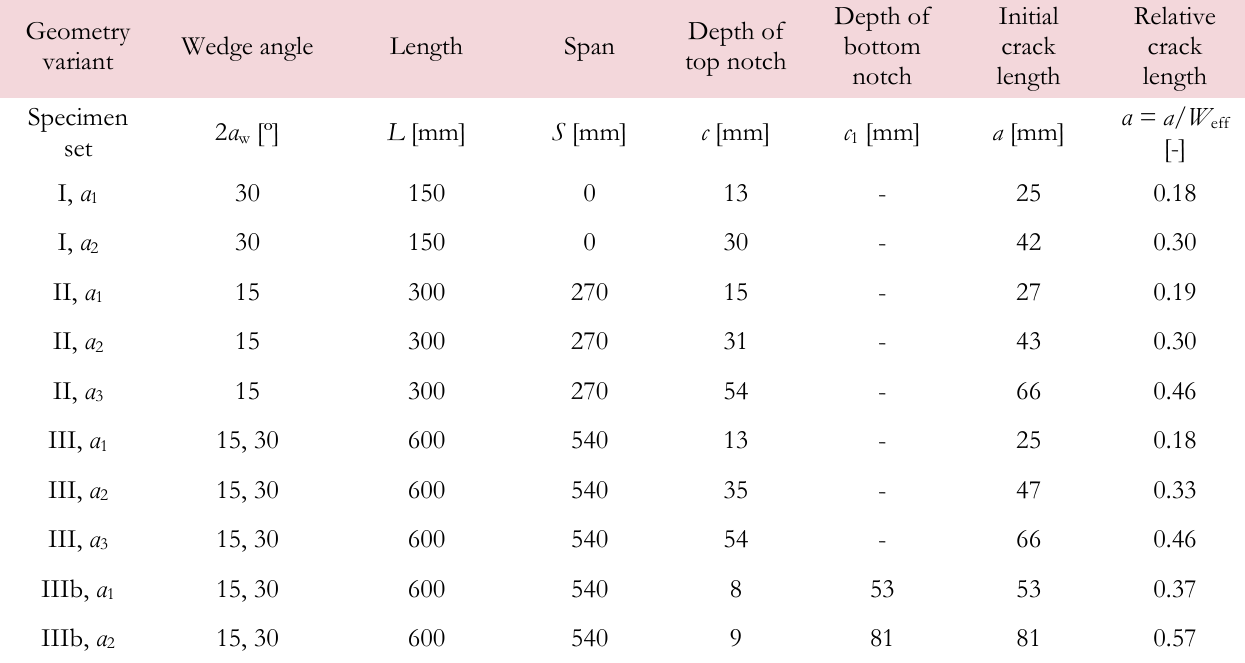
Table 2: Nominal variant dimensions and test geometry parameters, taken from